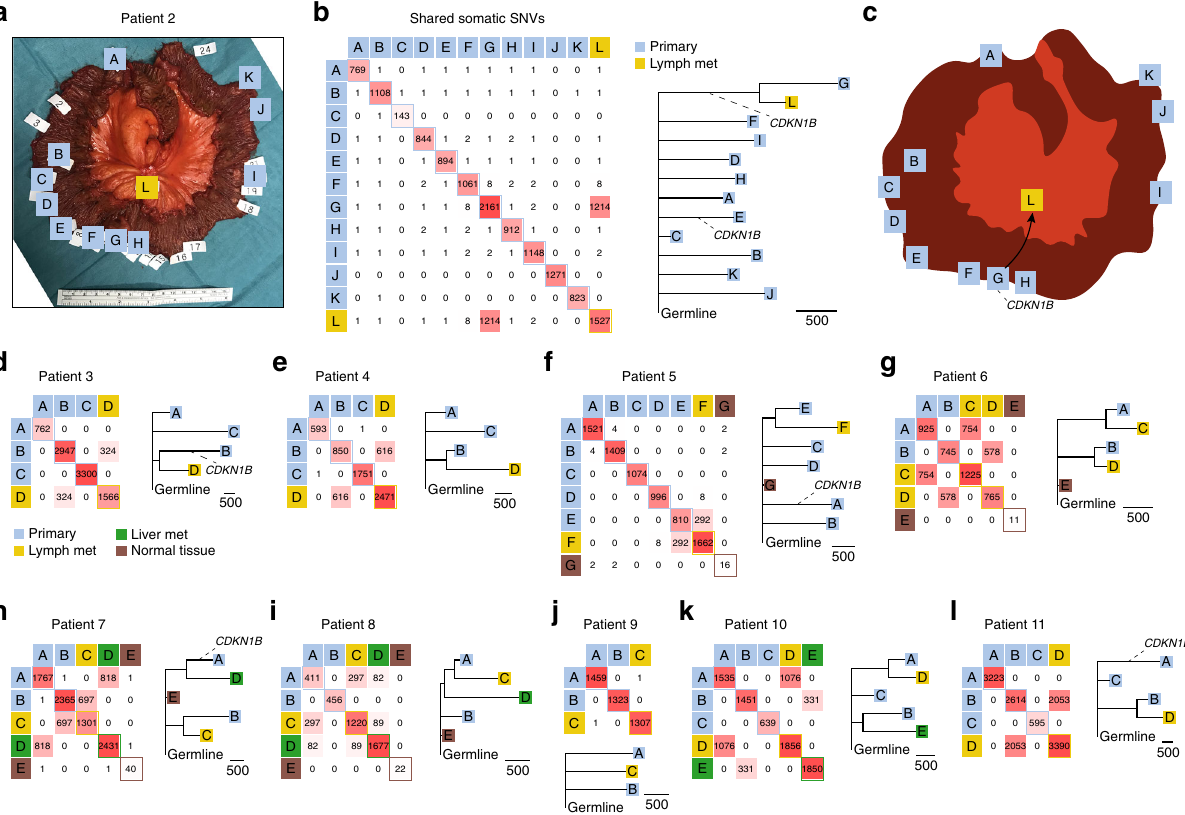
Fig. 2 Whole genome sequencing of 50 primary tumors and metastases from 10 additional SI-NET patients con fi rms independent clonal origin. a Section of the small intestine from a patient (Patient 2) harboring 11 primary tumors (A – K) and one lymph node metastasis (L). White labels indicate all identi fi ed tumors while letters indicate sequenced samples with suf fi cient purity and tumor material. b Pairwise analysis of shared somatic SNVs in Patient 2. Primary tumor G and the metastasis shared 1,214 mutations. The known CDKN1B driver event is indicated in the phylogenetic tree (the number of SNVs in each branch is given by the scale marker). c Proposed model. d – l Similar to panel b , based on archival material from nine additional patients that also included liver metastases and normal mucosa samples. Bootstrap support was 100% for all major branches in the phylogenetic trees. Met metastasis, SNV single nucleotide variant. Source data are provided as a Source data fi